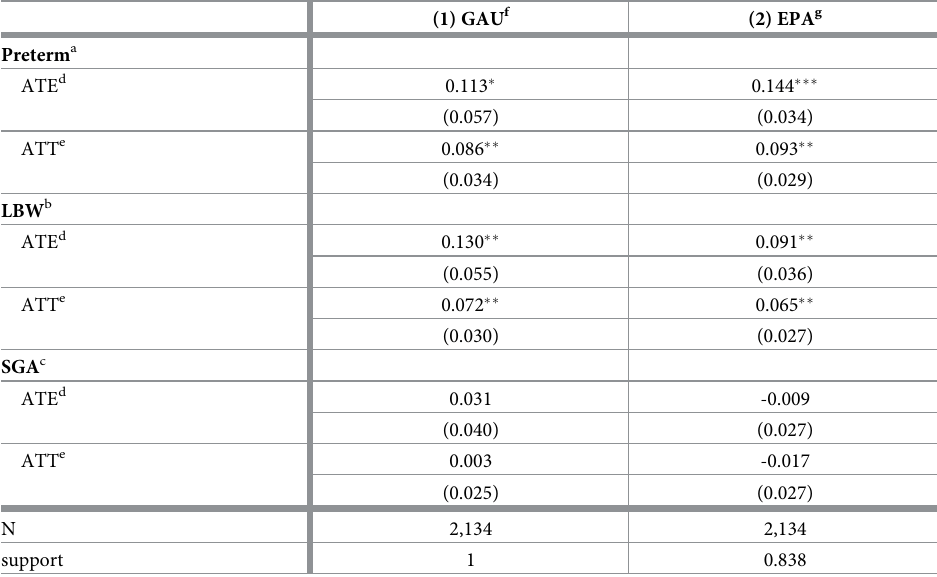
Table 2. Matching estimates for treatment